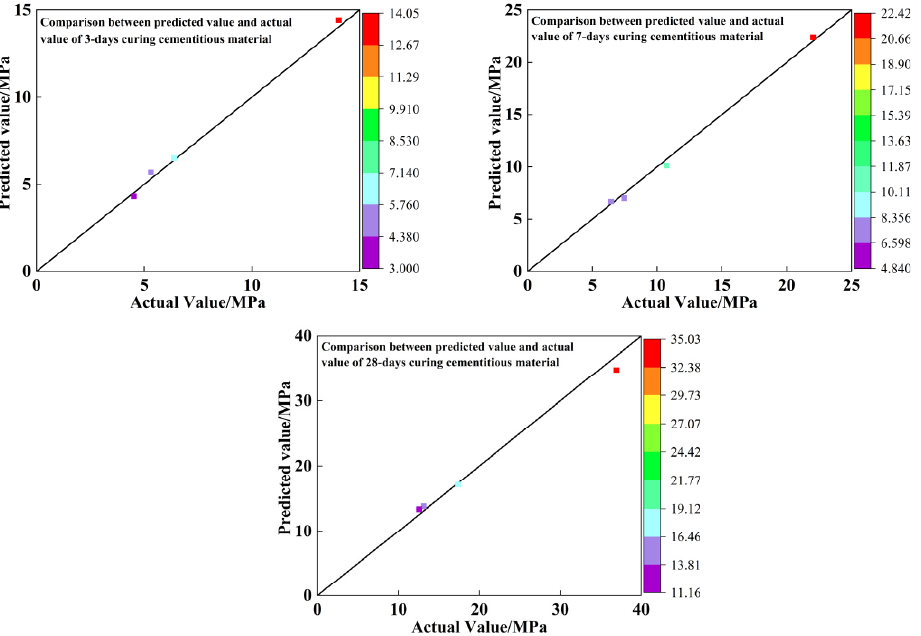
Figure 7. Comparison of predicted and actual values of compressive strength for different curing days.